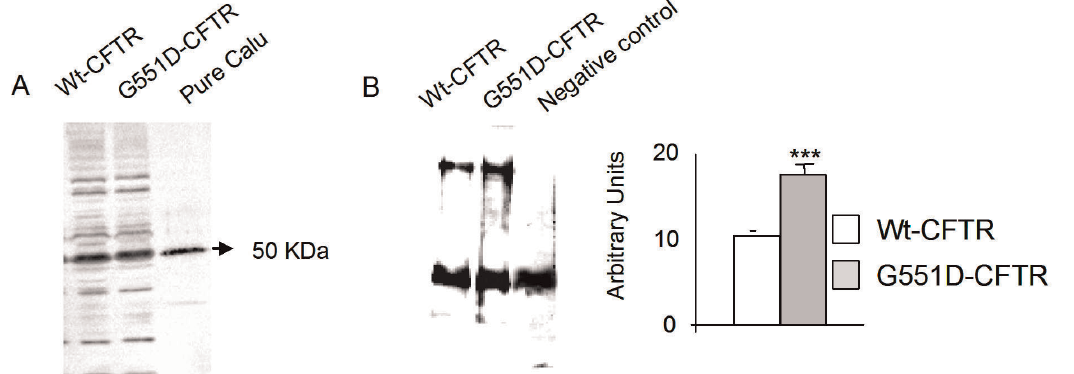
Figure 3. More calumenin is bound onto G551D-CFTR than onto Wt-CFTR. A, Example of detection of calumenin in Wt-CFTR and G551D expressing cells, assessed by western blotting using whole cell lysates. No difference was observed between the two cell lines. Pure Calumenin was loaded as a molecular weight control because of the presence of non-specific bands on the membrane. B, Example of coimmunoprecipitation showing the calumenin-CFTR interaction in total proteins (left). Histogram represents the quantitation indicating that more calumenin is bound onto G551D-CFTR than onto Wt-CFTR (right). doi:10.1371/journal.pone.0040173.g003 PLoS ONE |